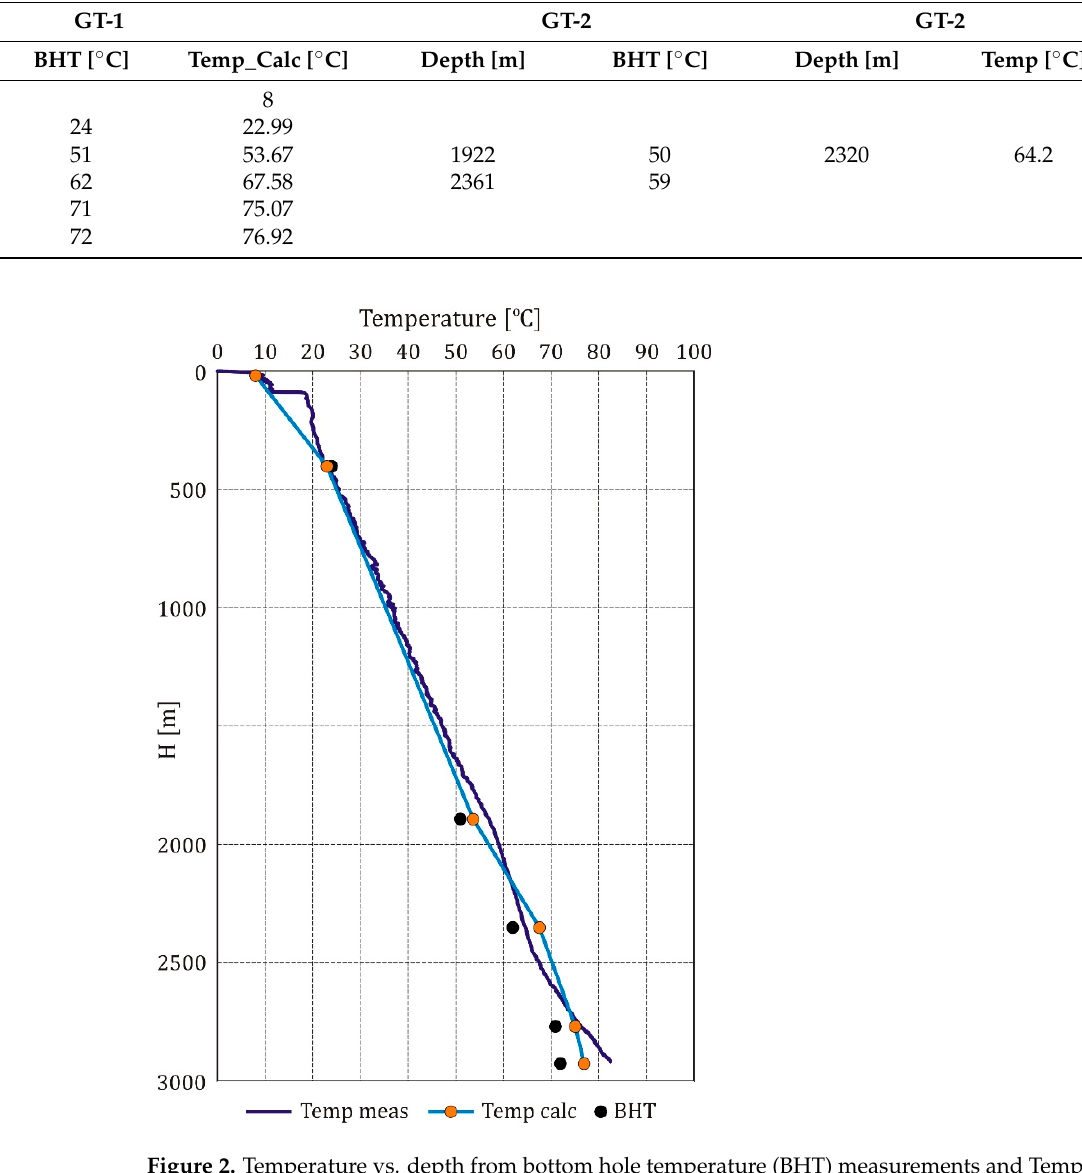
Figure 2. Temperature vs. depth from bottom hole temperature (BHT) measurements and Temp Log in GT-1; black points—BHT measurements, orange points—calculated temperature, violet line—Temp meas log.